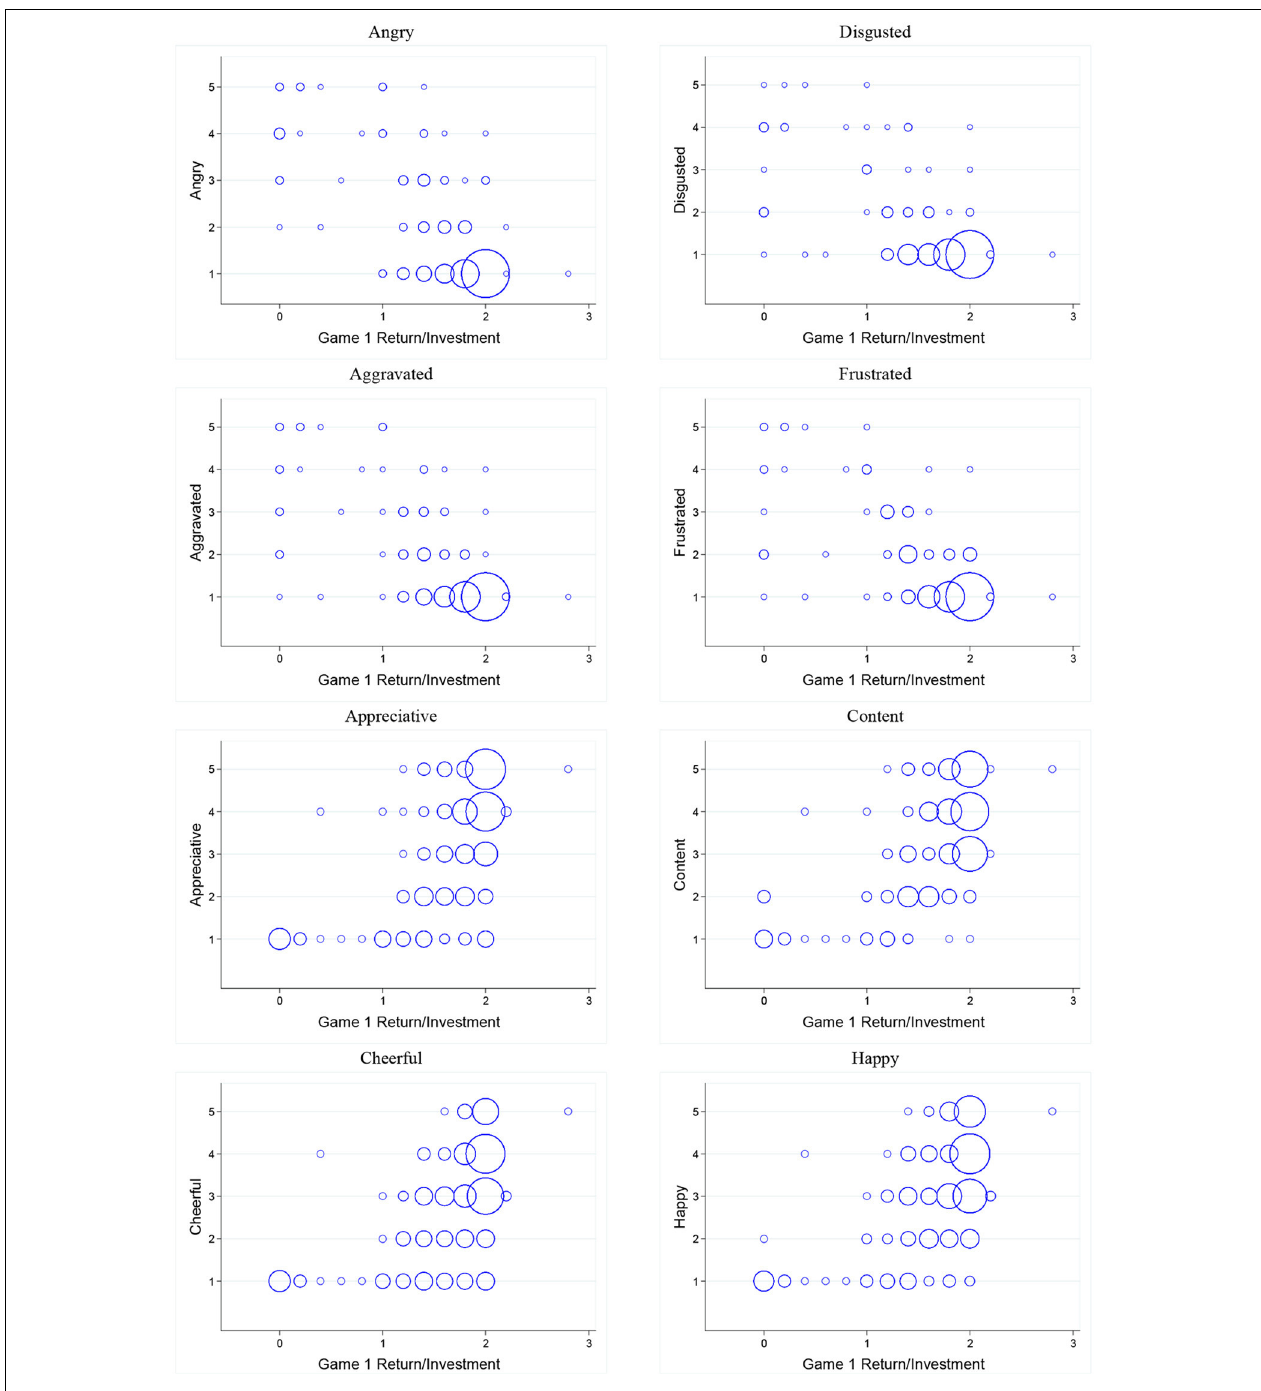
FIGURE 5 | Bubble plots of investors’ emotions and ROI